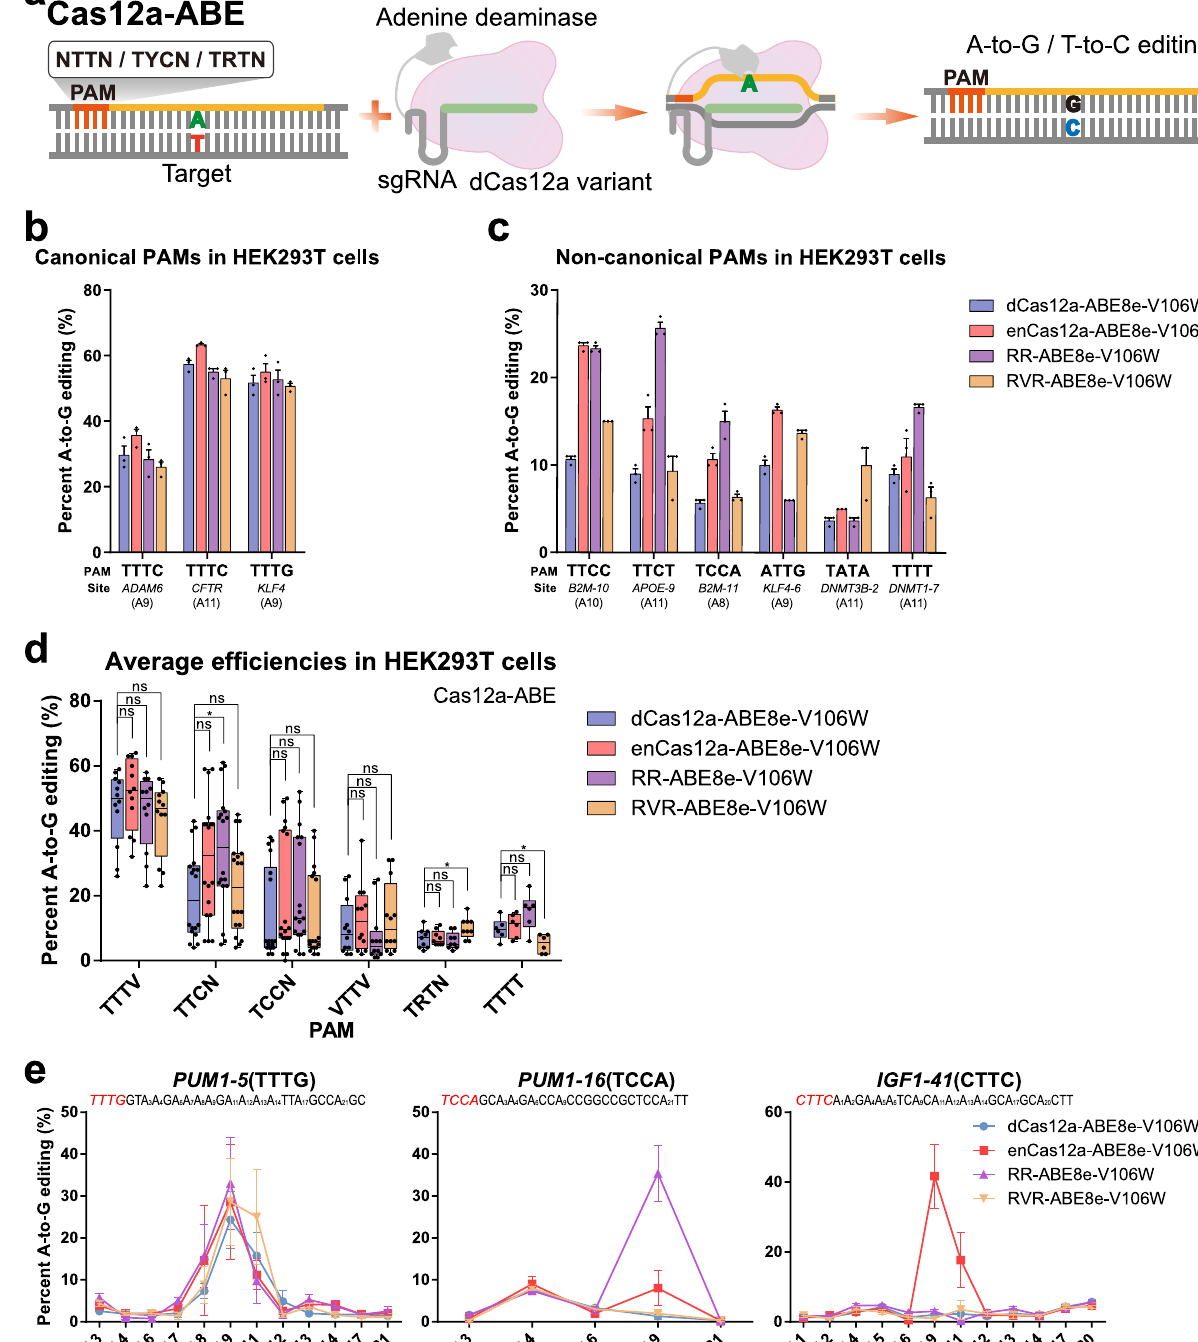
Fig. 2 Ef fi cient A-to-G conversion by Cas12a variant-mediated ABEs for non-canonical PAMs. a Schematic of A-to-G editing on targets with non- canonical PAMs by Cas12a variant-mediated ABEs. Ef fi ciencies of Cas12a variant-mediated ABEs, including dCas12a-, enCas12a-, RR-, and RVR-ABE8e- V106W, for canonical TTTV PAM ( b ) and non-canonical PAMs ( c ) in HKE293T cells ( n = 3). d Average ef fi ciencies of Cas12a variant-mediated ABEs at 14 sites in HEK293T cells with individual PAMs. Related to b , c , and Supplementary Fig. 10. e Ef fi ciencies of Cas12a variant-mediated ABEs for canonical TTTV PAM and non-canonical PAMs, TCCA and CTTC, in porcine embryos ( n ≥ 3). Values and error bars for b , c , and e represent the mean and SEM, respectively. For d , the boxplots show the median, fi rst quartile, and third quartile, and whiskers represent the maximum and minimum values. Statistical signi fi cance was calculated by unpaired two-tailed Mann – Whitney test. ns (not signi fi cant), p ≥ 0.05; * p <